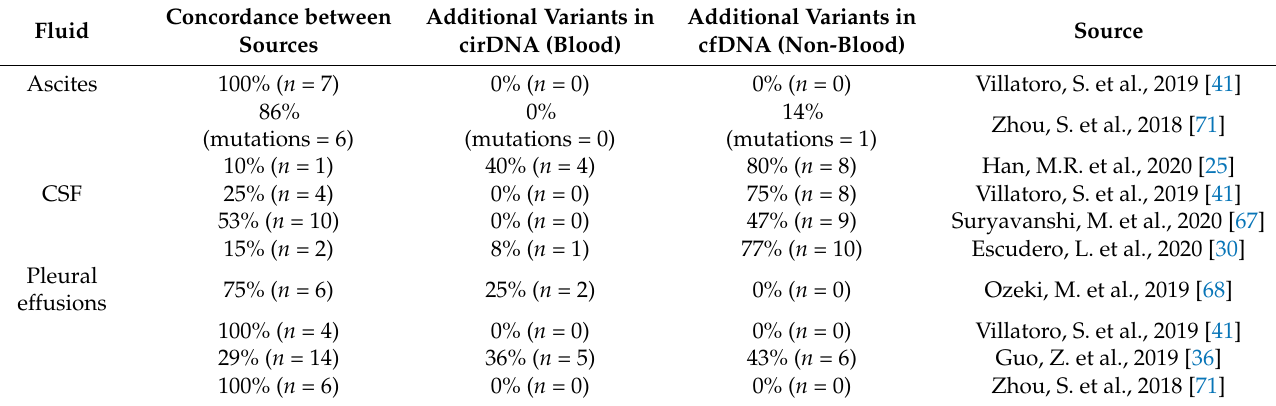
Table 2. Concordance in variants detected in cfDNA from blood plasma and body